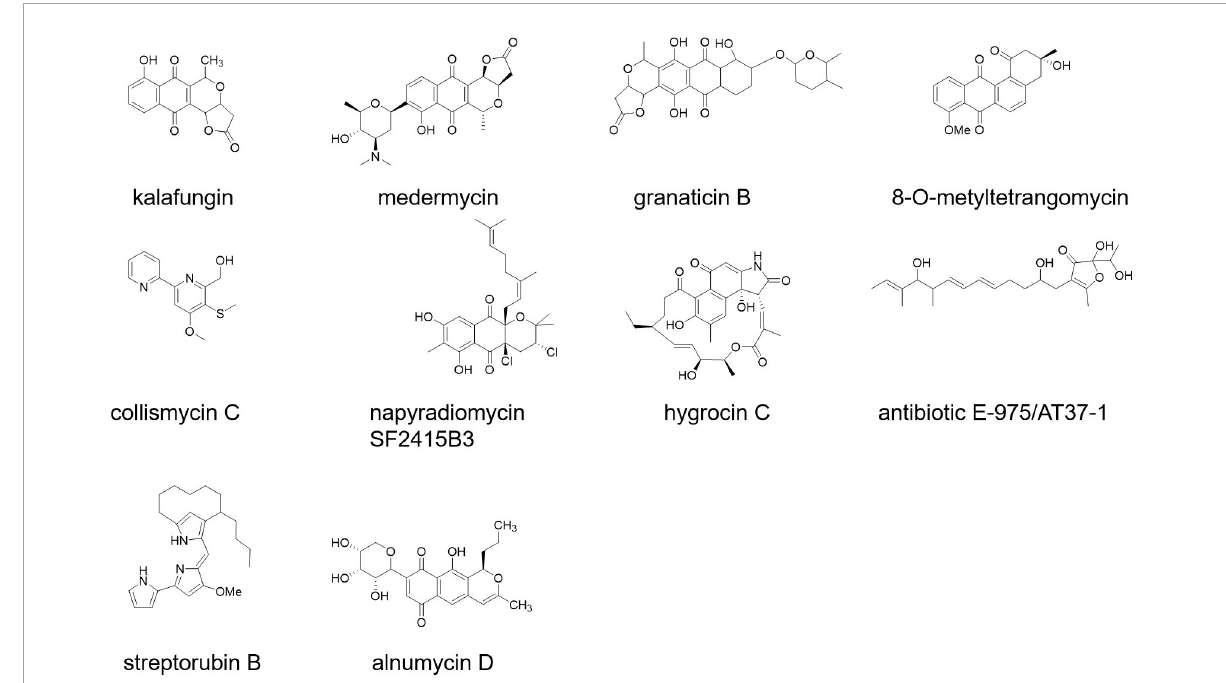
FIGURE3 Compounds with anti-methicillin-resistant Staphylococcus aureus (MRSA) biofilm